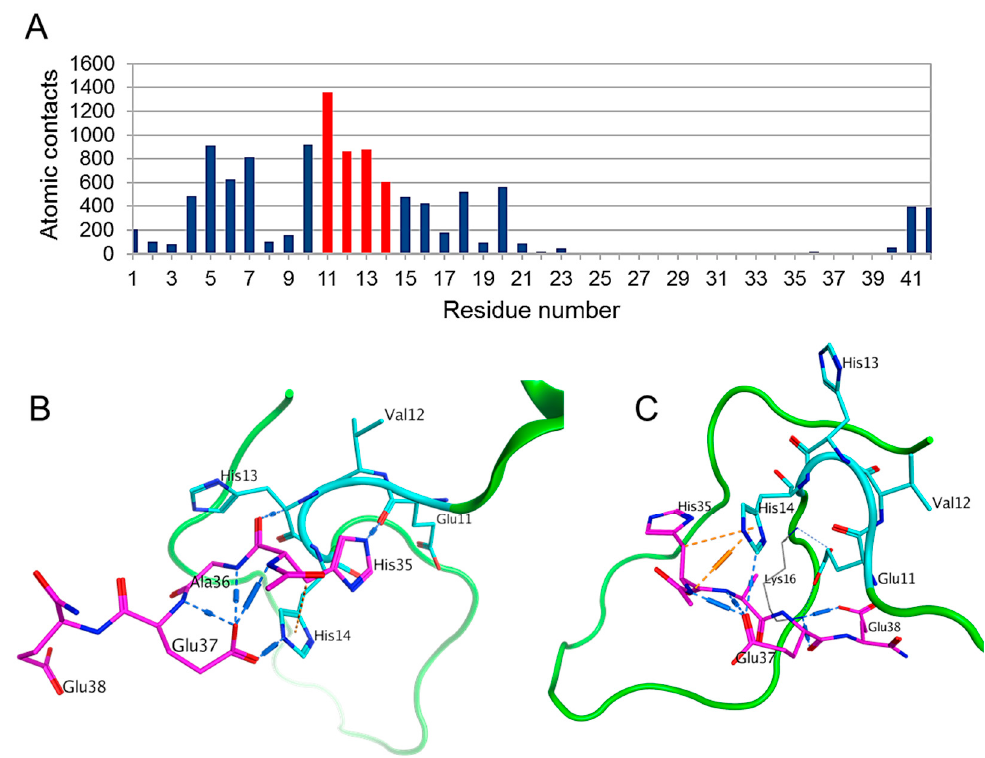
Figure 2. Global docking of Ac-HAEE-NH 2 to A β 42 . ( A ) A histogram of A β 42 atomic contacts to the Ac-HAEE-NH 2 tetrapeptide for the data from six docking servers. The position of the 11 EVHH 14 site is highlighted in red. Calculated by QASDOM [20] metaserver. ( B , C ) Examples of the docked Ac-HAEE-NH 2 peptide. The A β 42 peptide is colored green, with the 11 EVHH 14 site shown in cyan, and the Ac-HAEE-NH 2 tetrapeptide is colored magenta.